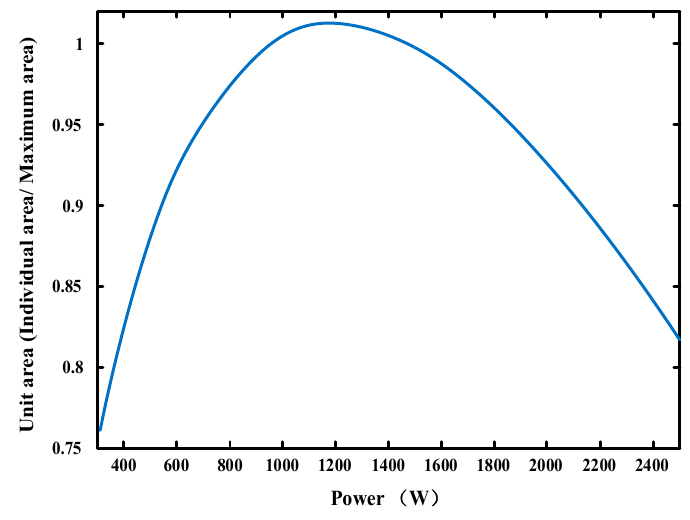
Figure 6. The area of rectangles for different CHP electrical output power.